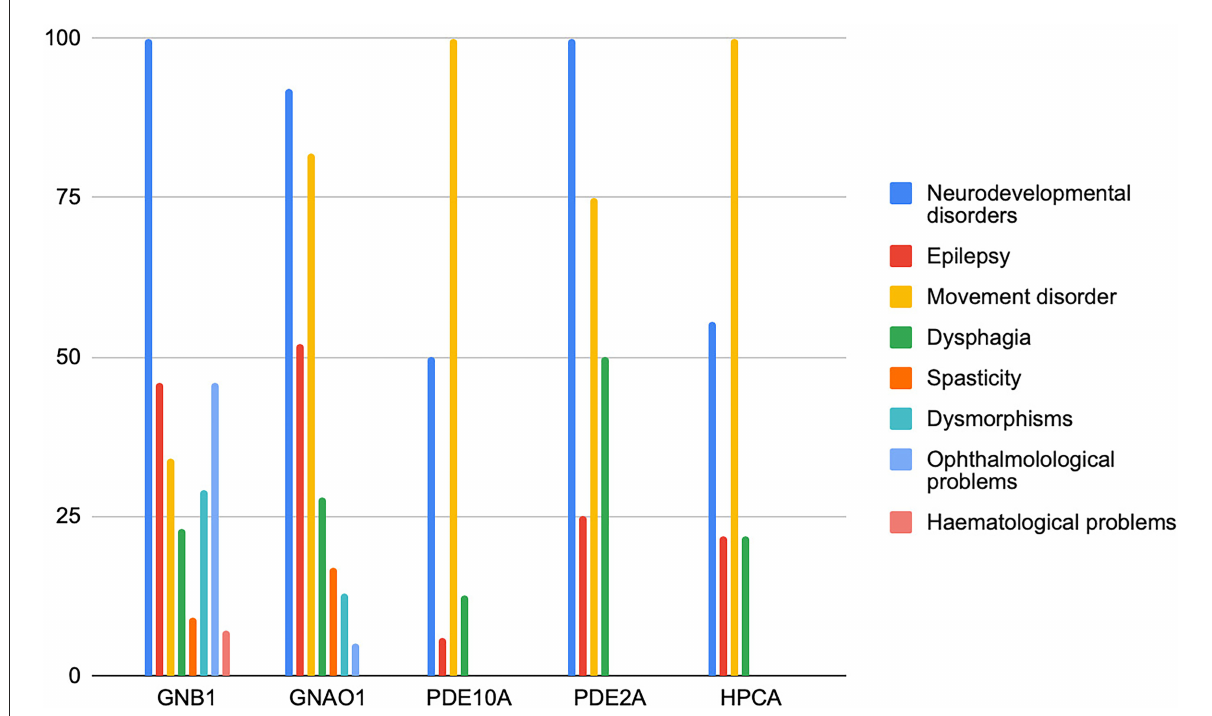
FIGURE2 Distribution of the main clinical features of genetic disorders affecting the GPCRs–cAMP signaling pathway. The frequency of symptoms is expressed in the percentage of